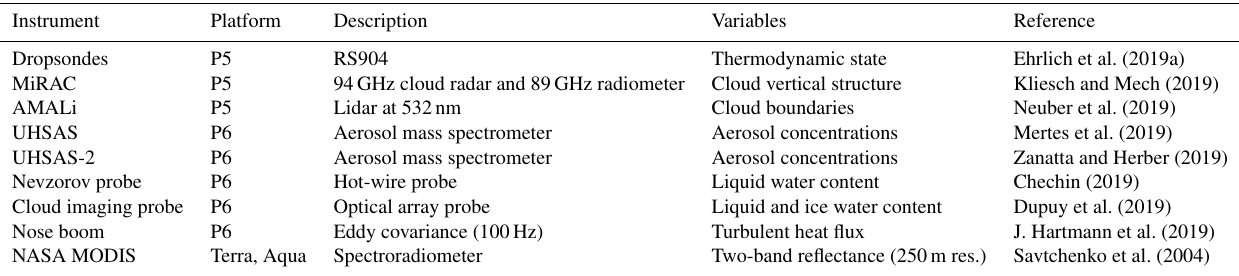
Figure 2. Time–height cross section of P5 MiRAC radar reflectivity Z e during RF20 (contour shading) and the indicated liquid cloud top from AMALi (black dots). The displayed longitude range corresponds to the orange target domain as shown in Fig. 1, while the lime green horizontal line indicates the simulated domain. The black arrows indicate the flight direction of the aircraft for each leg, with the start and end times indicated at the sides. The location of the dropsonde DS04 is indicated by the dotted dark-green vertical line. Table 1. Overview of the observational datasets used in this study. Data in rows 1–7 are accessible through the PANGAEA database, while the MODIS data are available through the NASA Worldview ∗